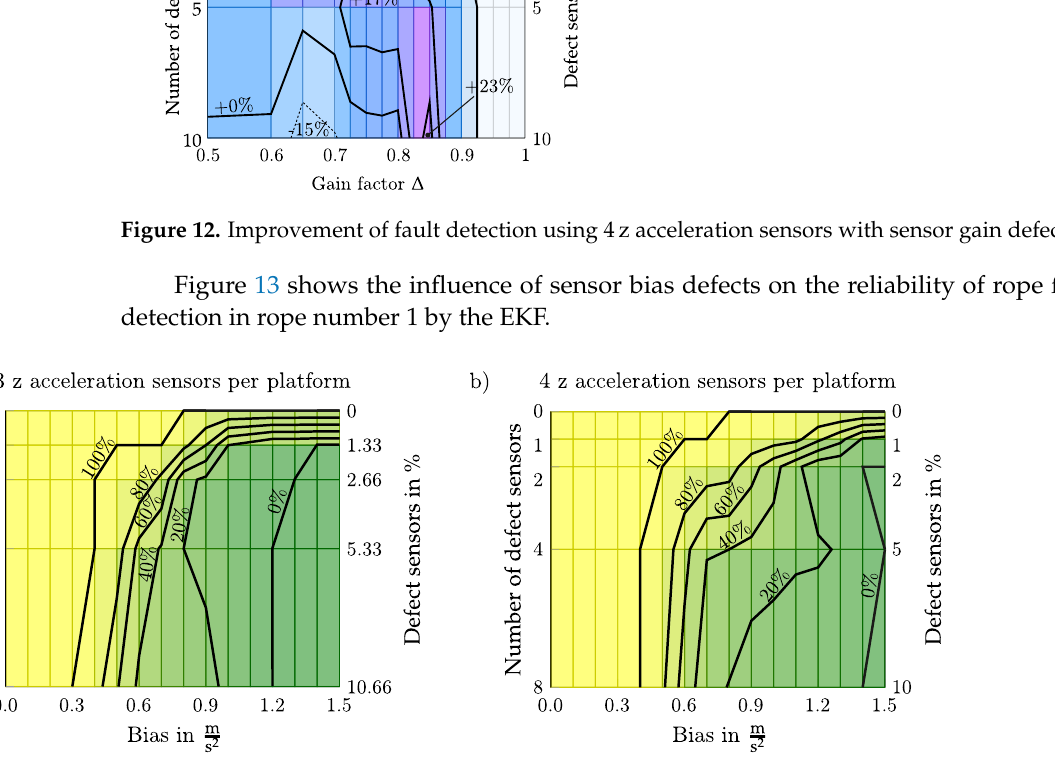
Figure 13. Impact of sensor bias defects on the percentage of correct detected rope faults by the EKF rope fault estimation for a rope fault in rope number 1. ( a ) 3z acceleration sensors and ( b ) 4z acceleration sensors per platform are